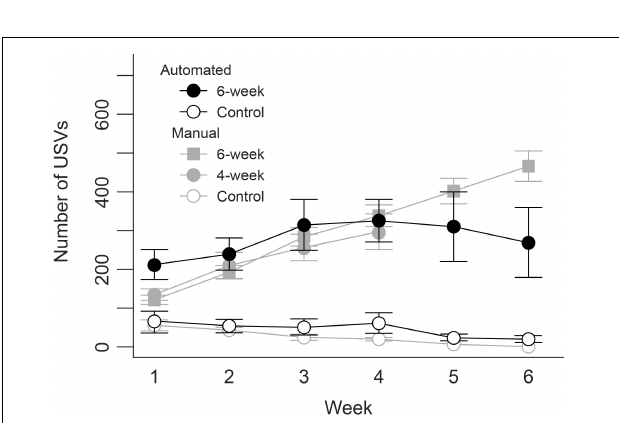
FIGURE 5 | Screenshot of the configuration settings in Avisoft RECORDER for automatic detection of ultrasonic vocalizations.